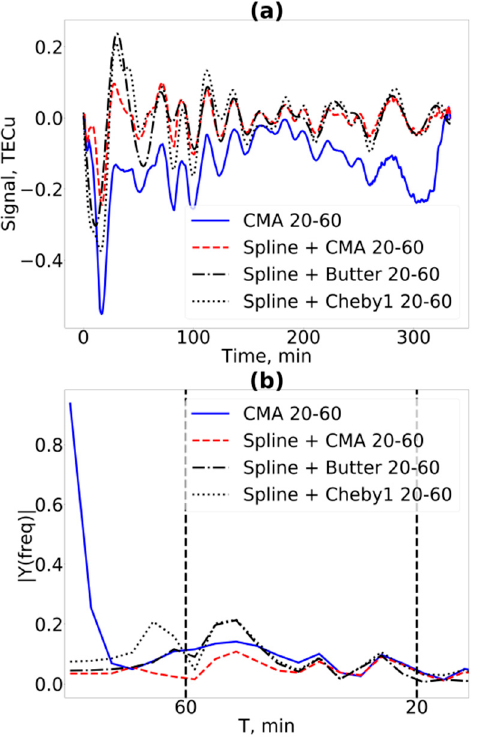
Figure 11. TEC variations obtained upon detrending and filtering through various techniques: ( a ) in the temporal domain; ( b ) in the frequency domain. The solid line corresponds to the CMA filtering (with a 20–60 min window). The other three cases correspond to, spline detrended TEC series with filtering based on the CMA (dotted line), Butterworth filter (dash-dotted line), and Chebyshev filter (dotted curve). Data from “UZUR - GPS26”.